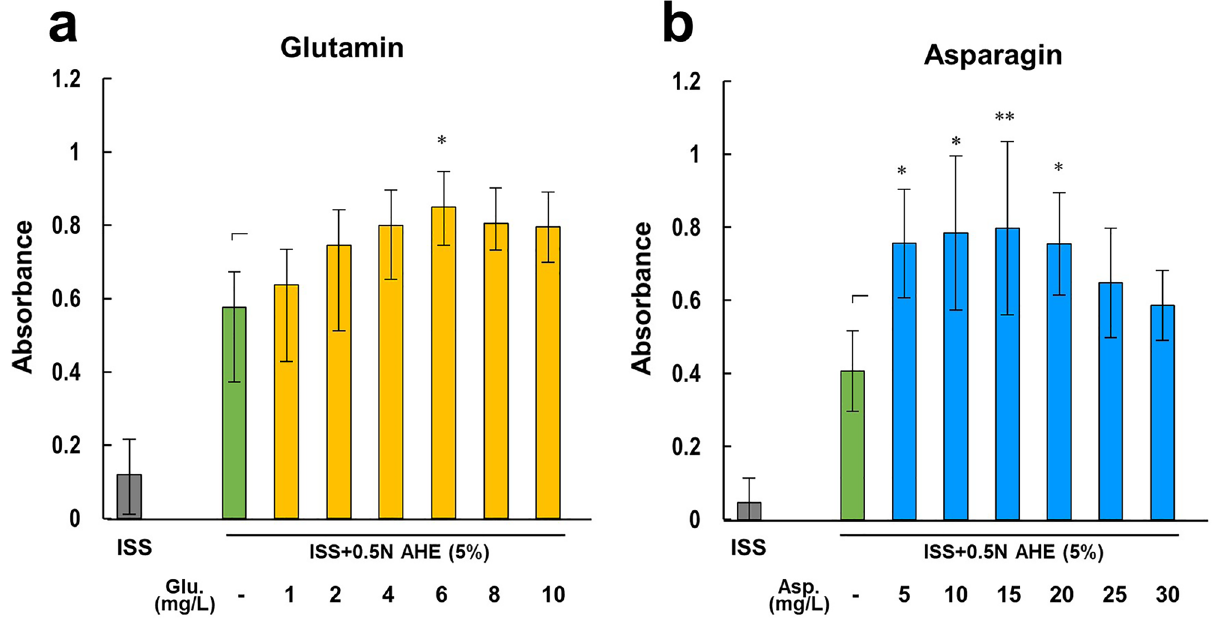
Figure 4. Glutamine and asparagine supplementation improved cell viability. RL34 cells were cultured in ISS containing 5% of 0.5 N AHE. Cell metabolic activity was measured after the addition of glutamine ( a ) or asparagine ( b ) in different doses. Data are presented as the mean ± standard deviation (n = 3–6). ** P < 0.01, * P < 0.05. AHE acid hydrolysis extract, ISS inorganic salt solution.